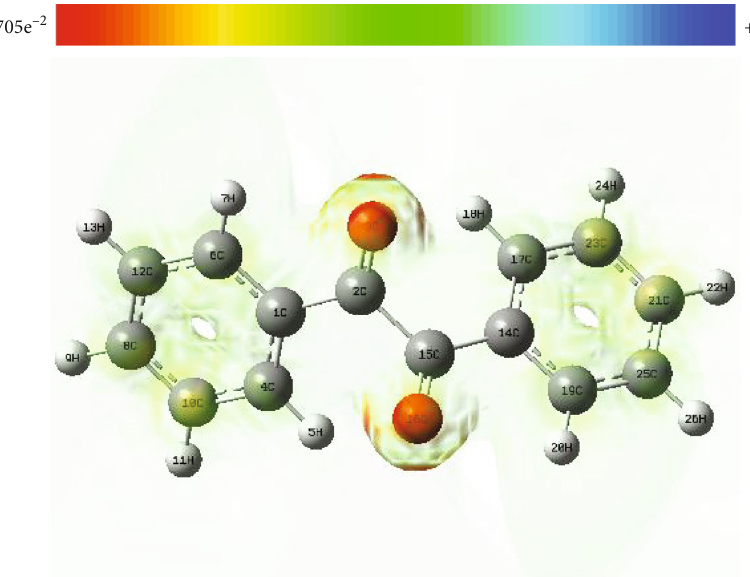
Figure 6: MEP map of